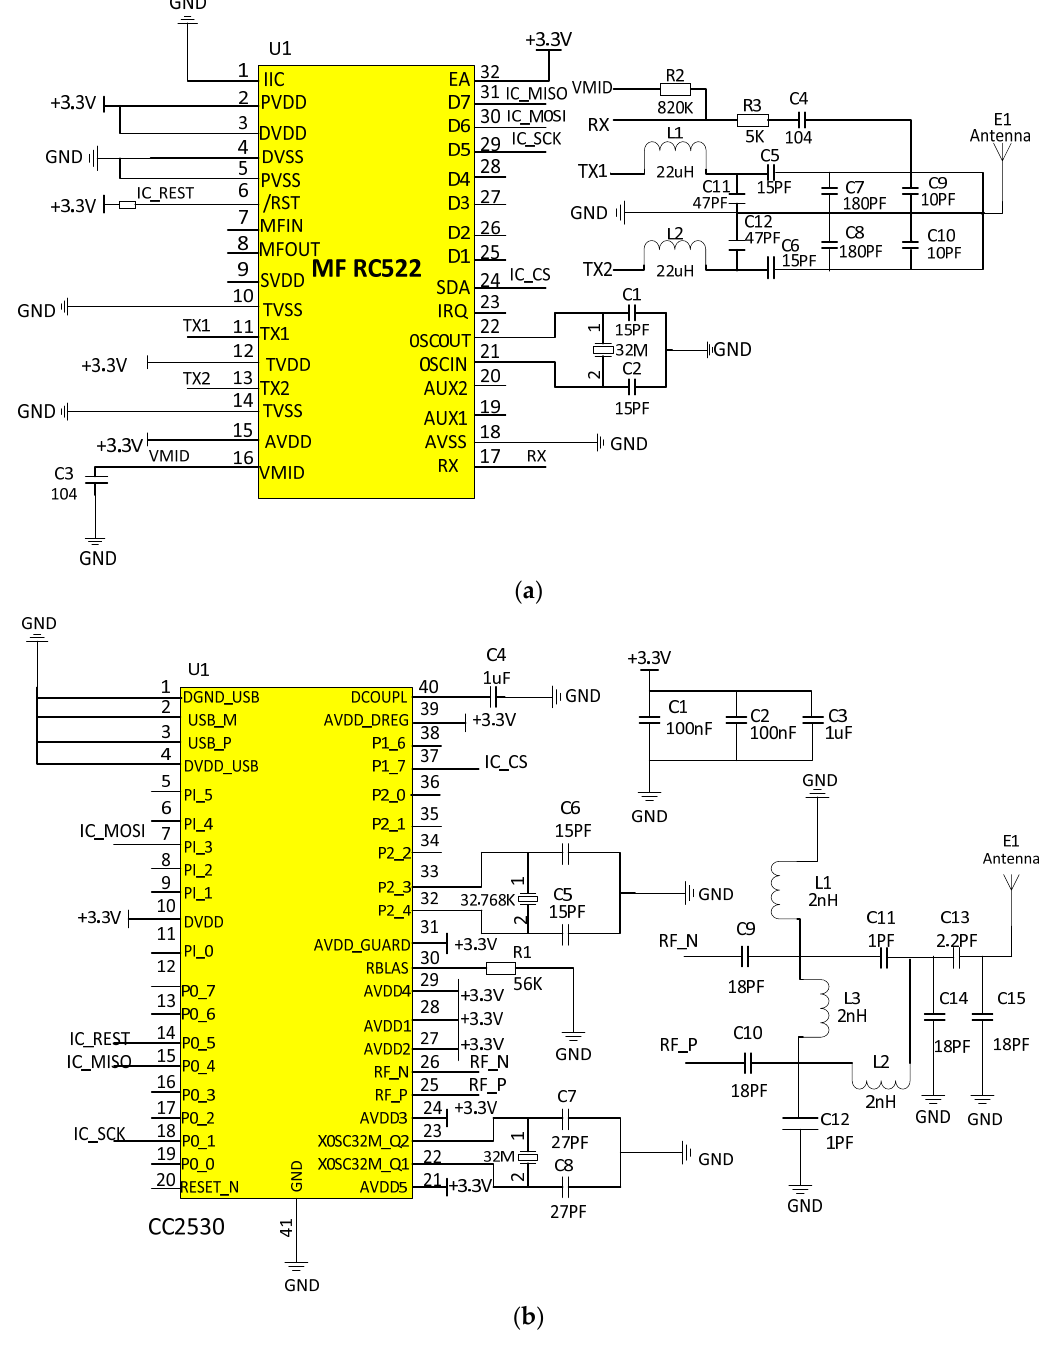
Figure 4. Schematic of the RFID reader/router ( a ) RFID reader system communication module and ( b ) ZigBee core control circuit.